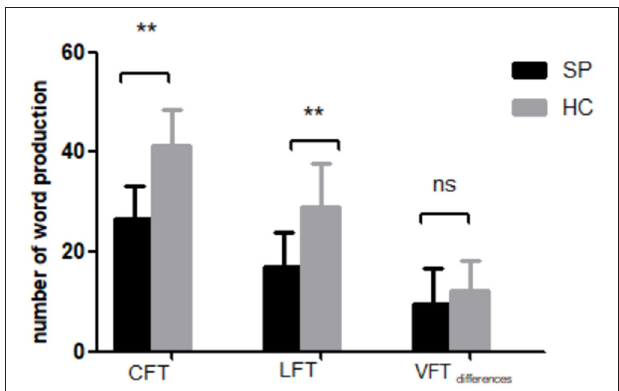
FIGURE 3 | Performance of SP and HC groups on the category fluency task (CFT) and letter fluency task (LFT). VFT differences = n CFT -n LFT . ** P < 0.001.